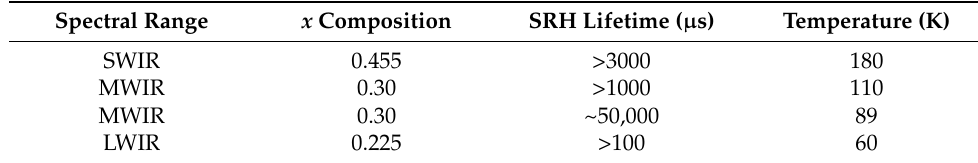
Table 1. Summary of the SRH carrier lifetimes determined based on current-voltage characteristics (data after reference